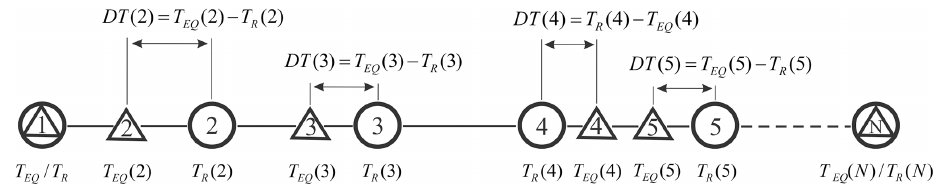
Figure 1. Explanation of the used approach. Triangles – time location of original earthquakes ( T EQ (i) ), circles – time location of regular markers ( T R (i) ). DT (i) denotes the difference between the time of earthquake occurrence ( T EQ (i) ) in the catalog and the time point of the regular marker ( T R (i)